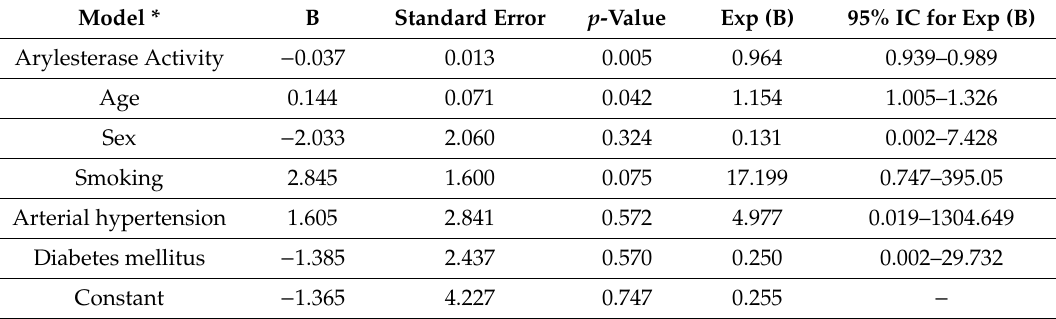
Table 3. Binary logistic regression analyses of selected variables showing their significant and independent association or not with the presence or absence of cancer.